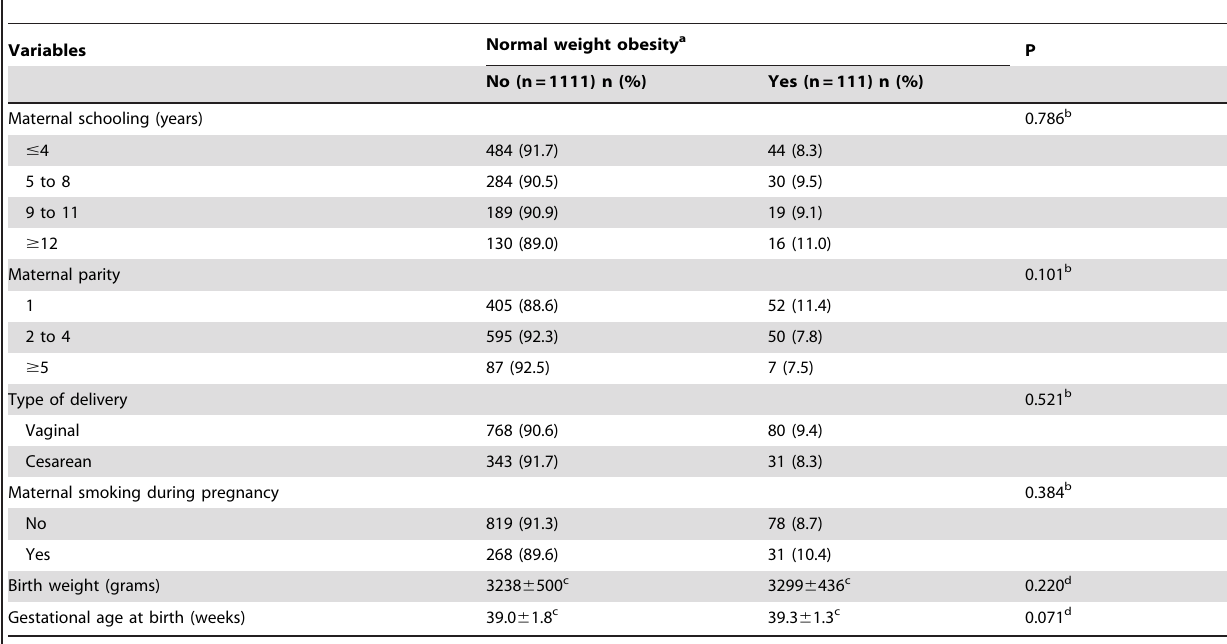
Table 2. Normal weight obesity according to early life variables, 1978/79 Ribeira˜o Preto birth